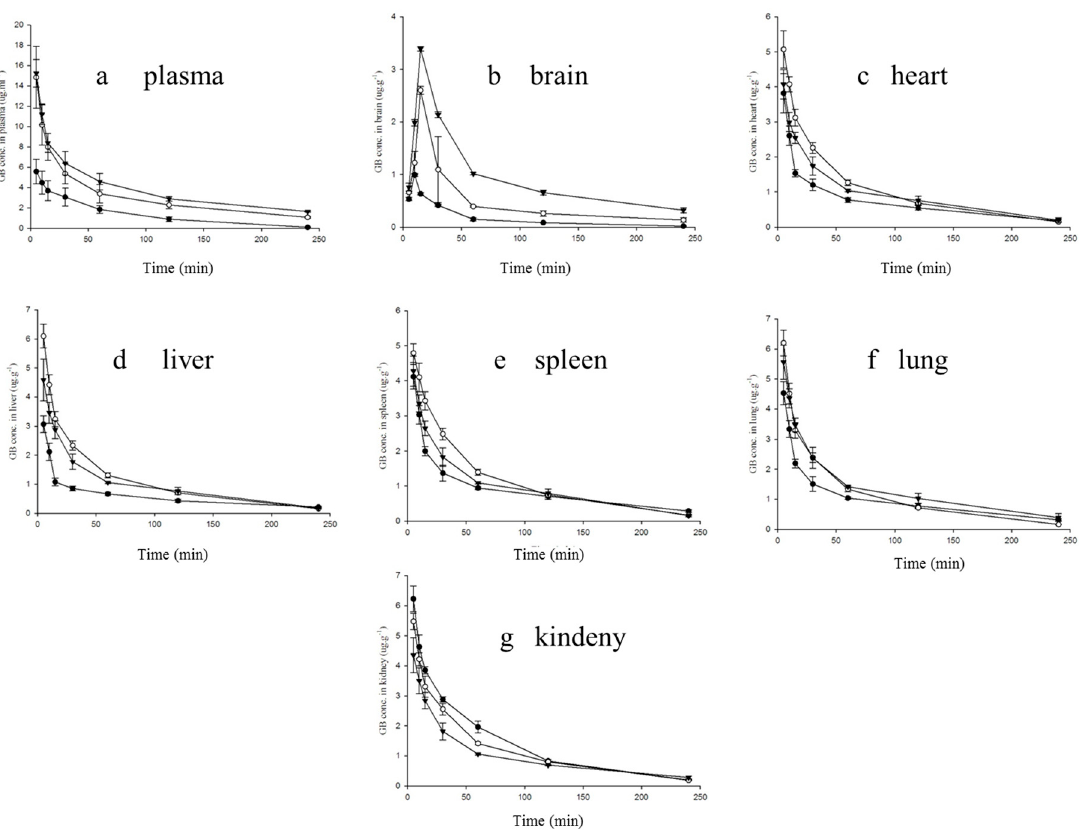
Figure 6. Mean GB concentration–time profiles in plasma ( a ); brain ( b ); heart ( c ); liver ( d ); spleen ( e ); lung ( f ) and kidney ( g ) after i.v. administration of GG-inj ( ● ), GG-LP( ○ ), GGB-LP( ▼ ) to mice ( n = 6, average ± SD). Table 5. The pharmacokinetic parameters of GB following intravenous administration to mice ( n = 6). Tissue